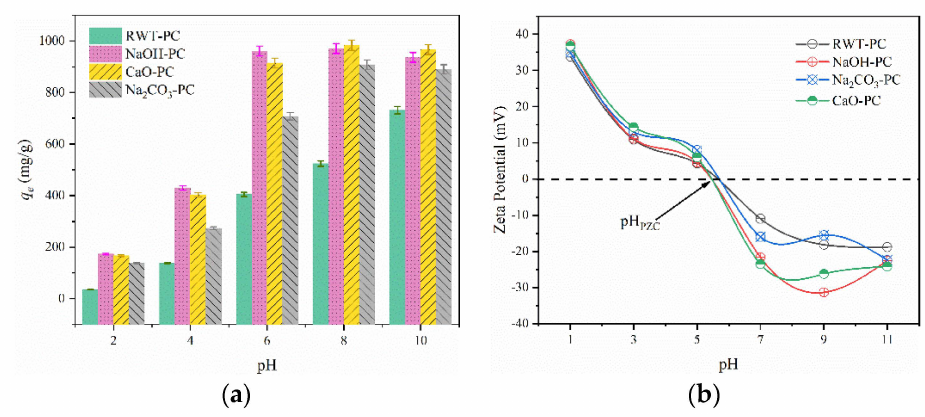
Figure 8. ( a ) Effect of pH on MG dye adsorption capacity (Dosage = 40 mg, MG concentration = 1000 mg/L, and T = 301 K) and ( b ) Zeta potential of four different